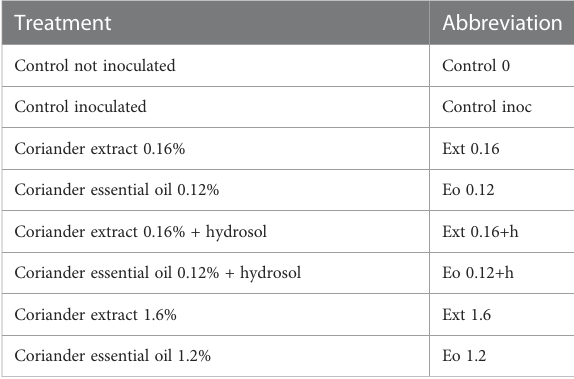
TABLE 1 Spraying mixtures for strawberry application under controlled